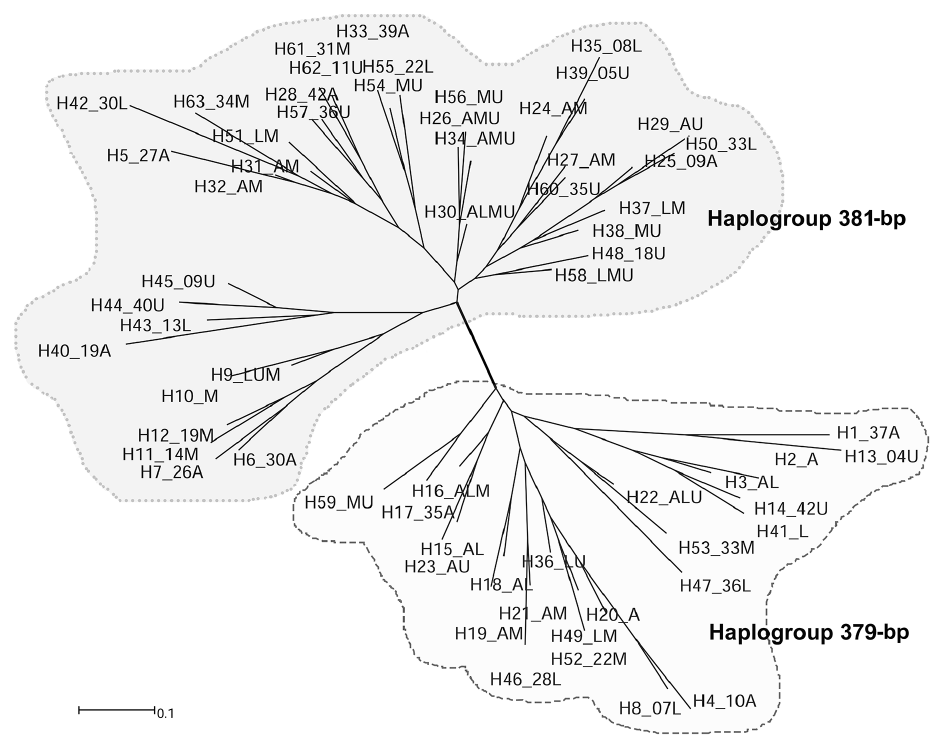
Figure 5. Neighbor-Joining unrooted dendrogram of “yerba mate” haplotypes. Each terminal (or leaf) corresponds to a haplotype (H1 – H63; see Table VI). Additionally, haplotypes shared among plantation sites have an indication of the sites from where they were registered (i.e., A, M, U, L), private haplotypes were labeled either by the plantation site´s identification letter or by the individual´s identification alphanumeric